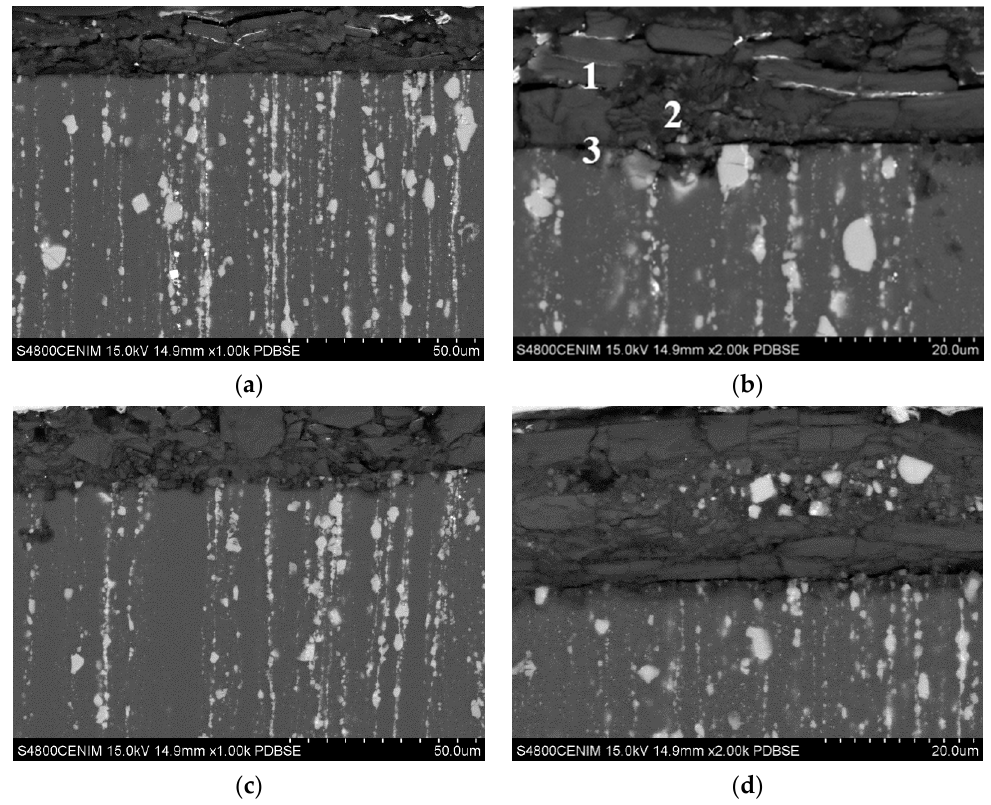
Figure 7. Secondary electron images of the surface condition of the corrosion scale formed on EZ51-IM350 alloy immersed in PBS solution. ( a , b ) 48 h, ( c , d ) 144 h.